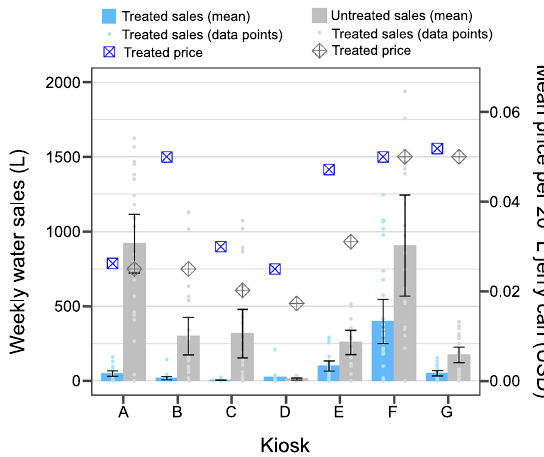
Fig. 4 Weekly water sales (L) and prices (USD) by kiosk. Error bars show 95% con fi dence intervals. For weekly water sales data points, outliers >2000 L are not shown.